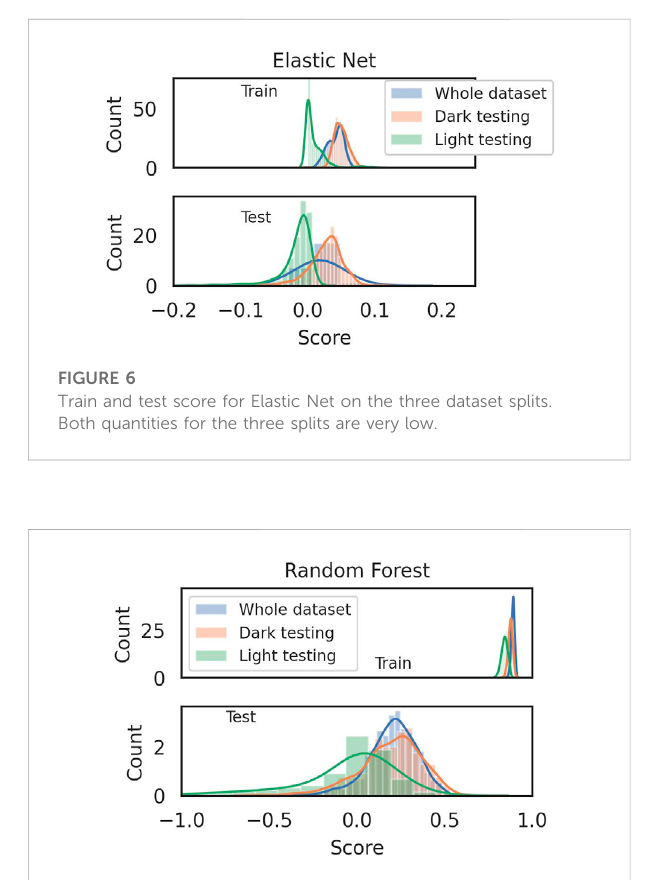
Figure S3) and selected two of them: Elastic Net (eNet), which is a linear model, and Random Forest (RF), which is a non-linear model.